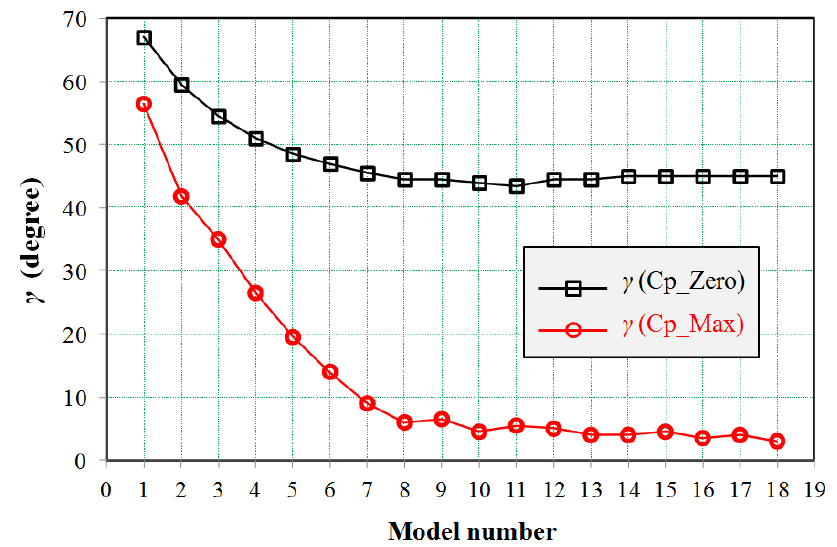
Figure 10. Position angles of the maximum positive Cp and zero Cp in the windward wall. Figure 11 depicts the point-maximum negative Cp and area-averaged Cp over the top region. In this figure, the pressure in each simulation case is normalised by the inflow dynamic pressure at the apex height H . The lowest Cp occurred at the apex position for all the simulations, and the magnitude of the lowest Cp value gradually increased until Model 10. The magnitude of the lowest Cp then marginally decreased for the remaining models. For Models 13–18, in which the sphere was located above the ground, the changes